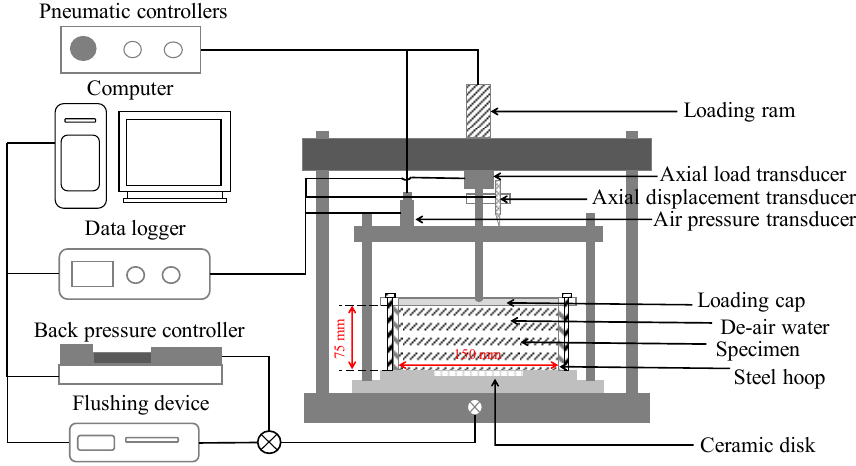
Figure 2. A schematic view of the LSSTA.